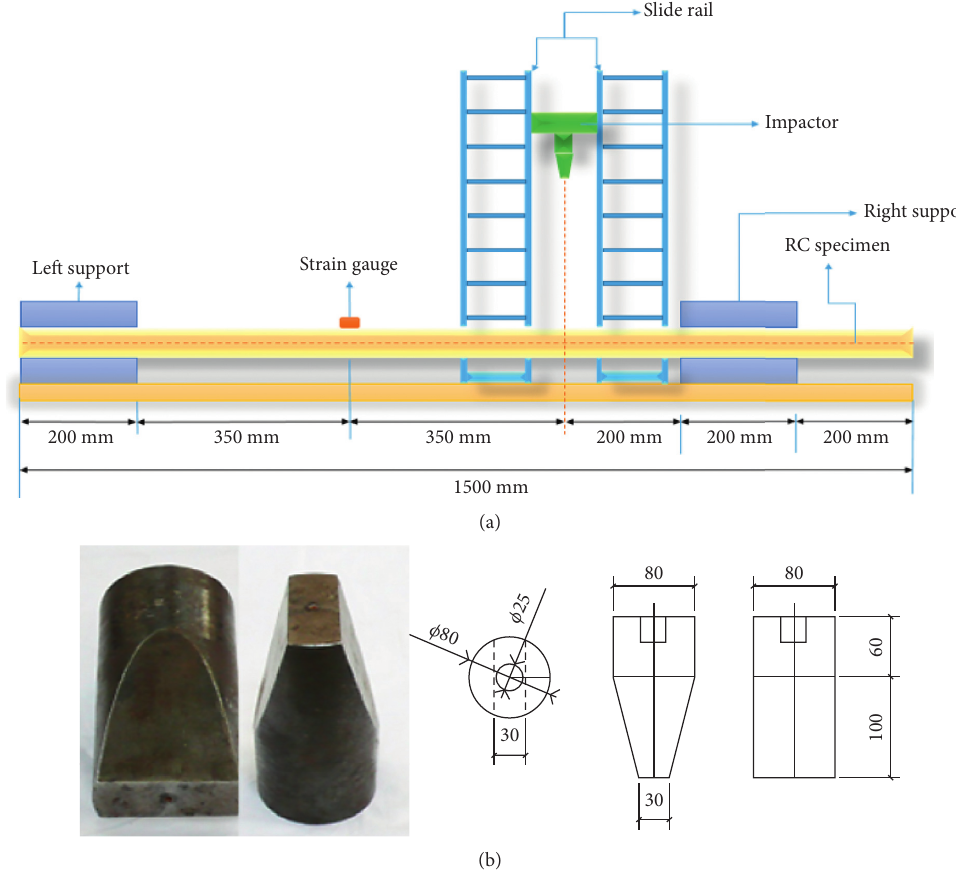
Figure 2: (a) Diagram of the strengthening process. (b) Details of the drop hammer.